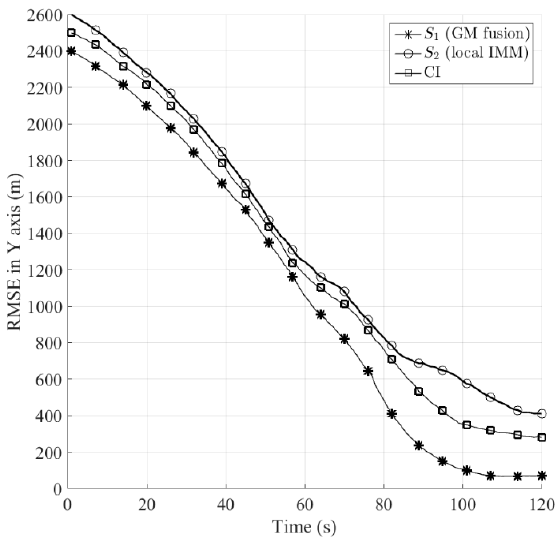
Figure 11. Comparison of RMSE in X axis between the proposed Gaussian mixtures (GM) fusion, local IMM and CI.